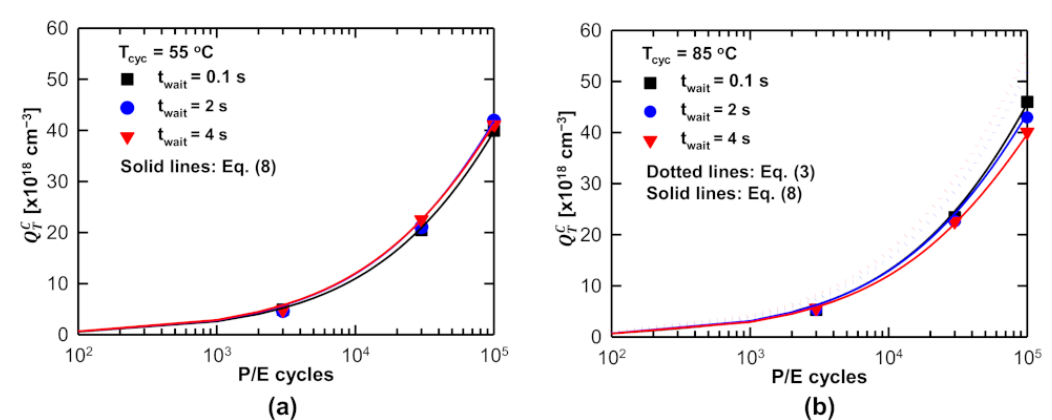
Figure 16. Q C obtained by fitting experimental data using Equation (8) for different values of t wait under T cyc of ( a ) 55 °C T and ( b ) 85 °C. Reprinted from [47].